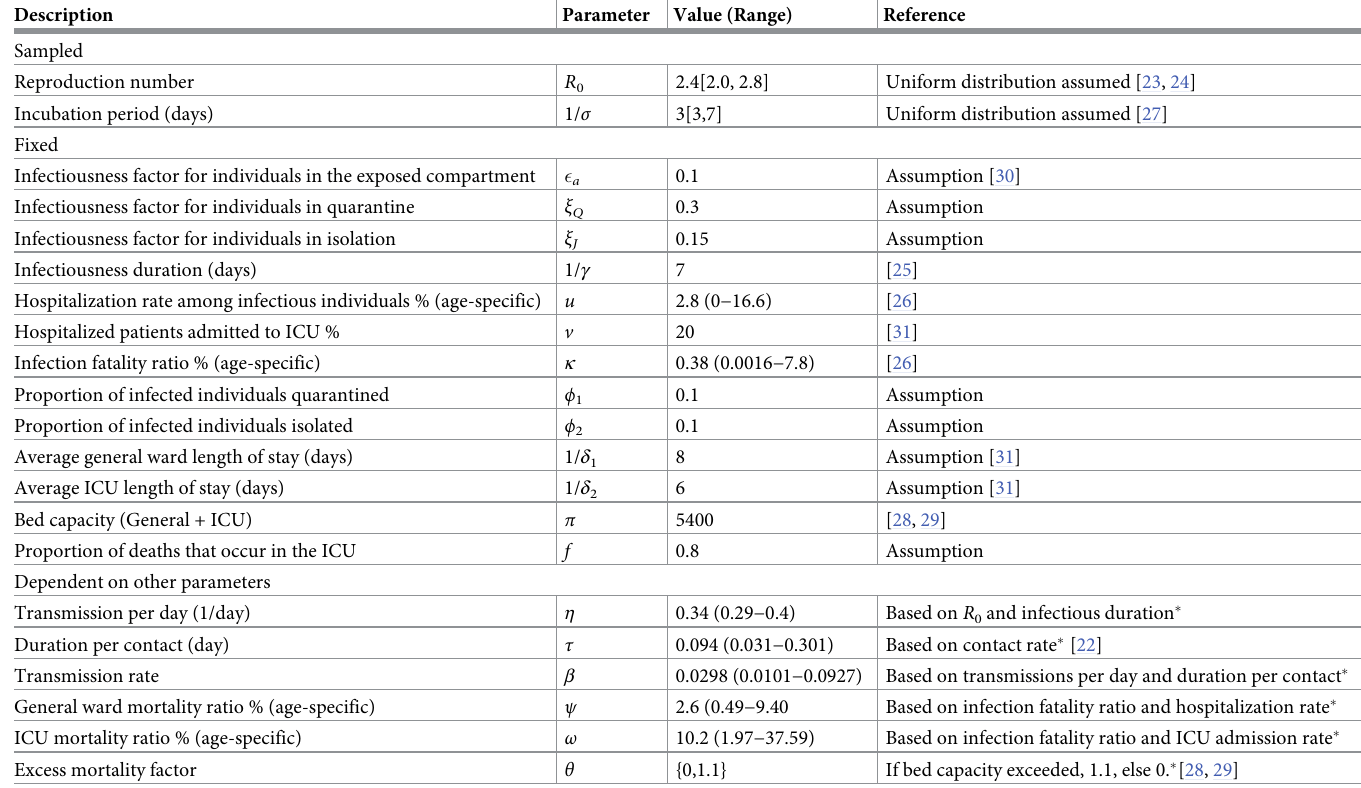
Table 1. Parameters for COVID-19 transmission dynamics in Kathmandu,